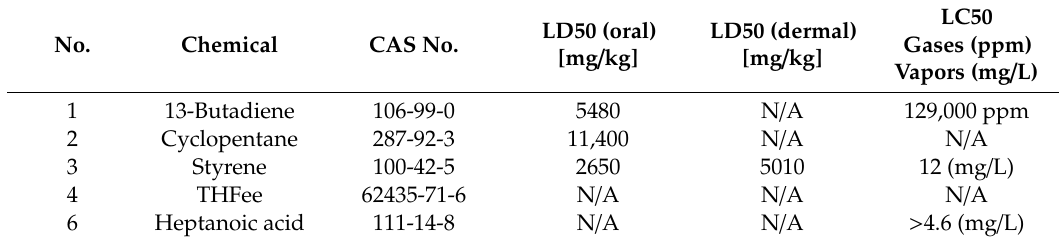
Table 13. Chemicals in SSBR solvent-related process.